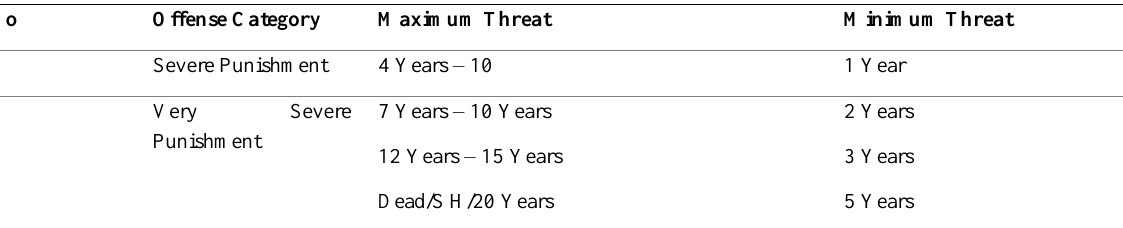
Table 2: Offense Category and